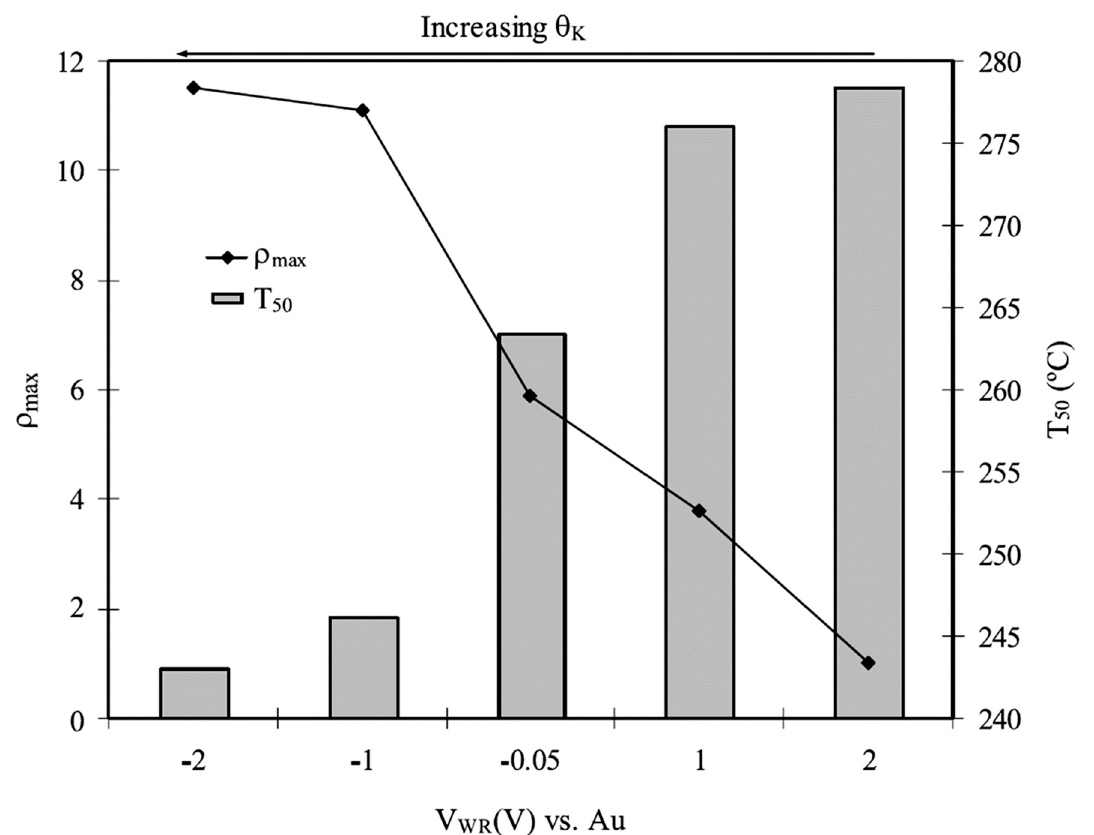
Figure 6. Effect of catalyst overpotential (VWR) on the maximum rate enhancement ratio ( ρ max ) and on T 50 of CO oxidation on Pt. Conditions: [CO] = [O 2 ] = 0.5% He balance, F t = 108 cm 3 /min. Data was acquired in a Pt/(K) β ”Al 2 O 3 /Au galvanic cell. (Reprinted with permission from Ref. [27]; Copyright 2008, Elsevier).